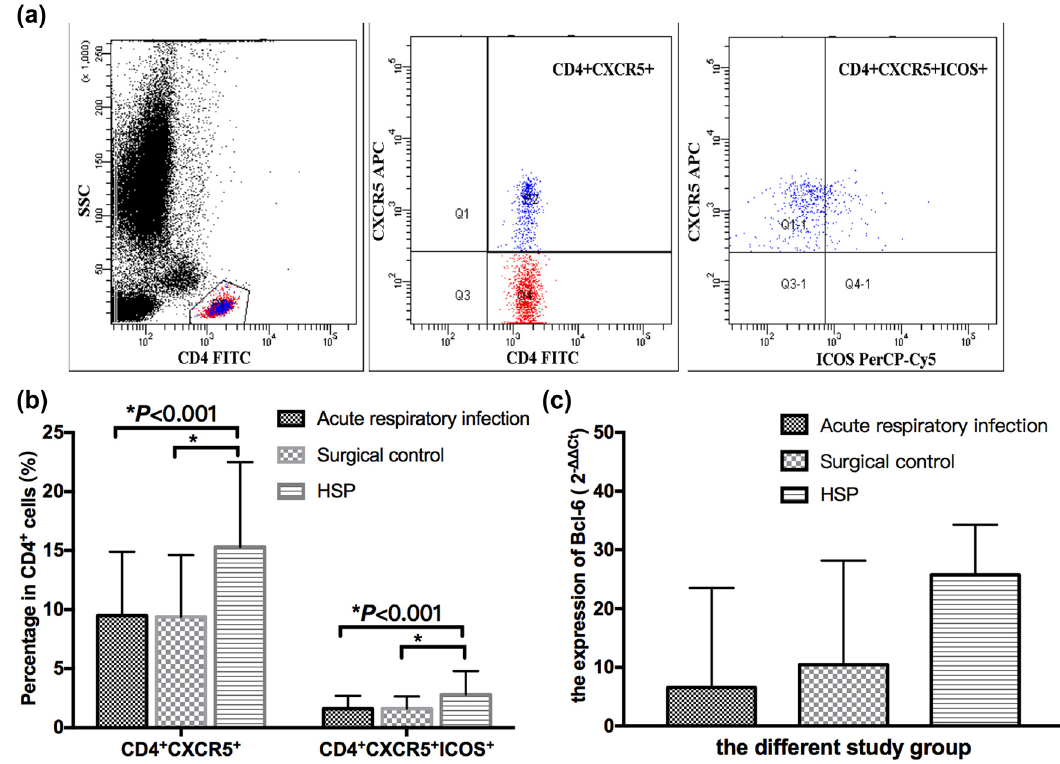
Figure 1: CD4 + CXCR5 + , CD4 + CXCR5 + ICOS + Tfh cells and Bcl - 6 expression in the HSP children and control group. ( a ) The gating strategy for Tfh cell analysis, and the percentages of CD4 + cells, CD4 + CXCR5 + and CD4 + CXCR5 + ICOS + Tfh cells were obtained in sequence. ( b ) The proportion of CD4 + CXCR5 + and CD4 + CXCR5 + ICOS + Tfh cells was signi fi cantly higher than that of the acute respiratory tract infection and surgical control group ( P < 0.001 ) . No statistical di ff erences were noticed in the proportion of CD4 + CXCR5 + and CD4 + CXCR5 + ICOS + Tfh cells between the acute respiratory tract infection and surgical control ( P > 0.05 ) . ( c ) No statistical di ff erences were noticed in the Bcl - 6 expression among the acute respiratory infection group, surgical control and HSP groups ( P > 0.05 )